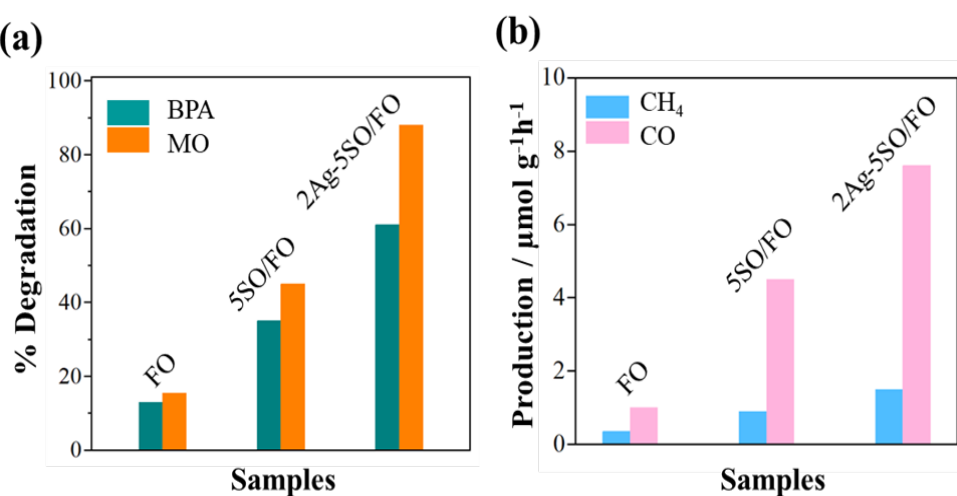
Figure 5. Applicability of the FO-based photocatalysts (FO, 5SO/FO, and 2Ag-5SO/FO) for the visi- ble-light aerobic degradation of ( a ) MO and BPA; ( b ) and CO 2 reduction.